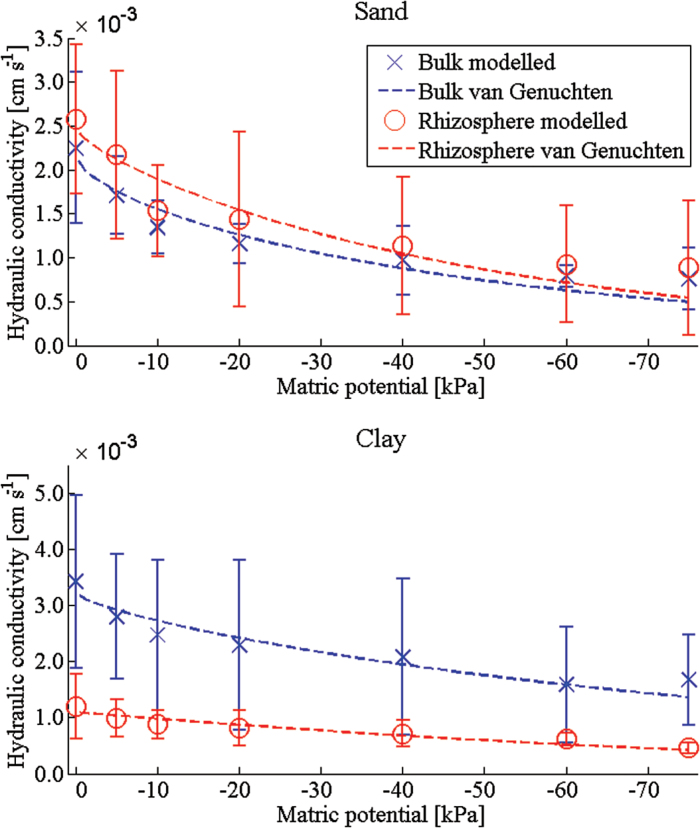
Calculated hydraulic conductivity values for clay and sand soils. Data are plotted for bulk and rhizosphere soils, and a van Genuchten curve has been fitted through these data using a non-linear least squares method. The parameters are given in Table 1. (This figure is available in colour at JXB online.)